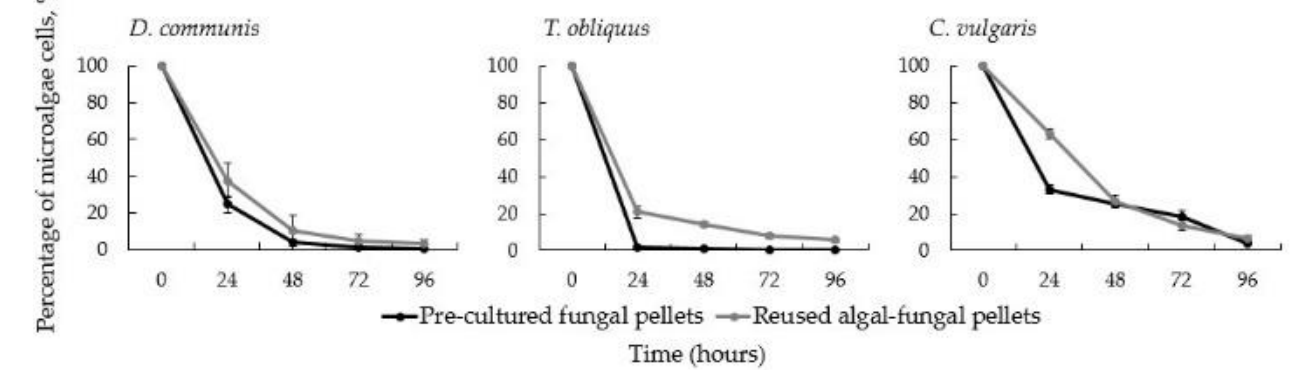
Figure 4. Percentage of selected microalgae remaining in the suspension when pre-cultured I. lacteus and recycled algal — I. lacteus pellets are used for respective microalgae bio-flocculation. Standard deviation represents the average from three replicates.